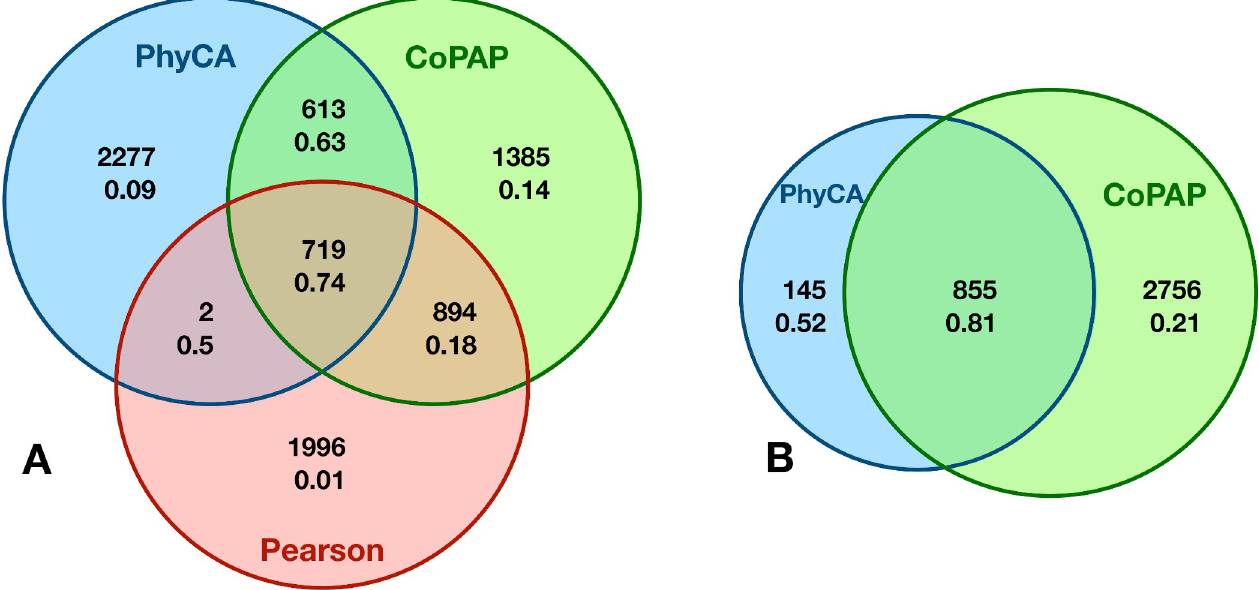
Fig 3. Comparison of simple correlations, phyletic couplings and phylogeny-corrected correlations. – Panel A shows a Venn diagram for the 3,611 first predictions of each of the three coevolution measures as extracted by Pearson correlation (red), PhyDCA (blue) and CoPAP (green). Numbers are the size of the corresponding intersection, and the PPV indicating the fraction of true positives according to our list of positive domain-domain interactions. Panel B compares the first 3,611 CoPAP predictions of highest possible significance, with the most significant 1,000 PhyDCA predictions. Most of them (855) are found to be significant by CoPAP, and of very high PPV (81%). However, not all CoPAP pairs are strongly coupled, and thus PPV is reduced (21%).